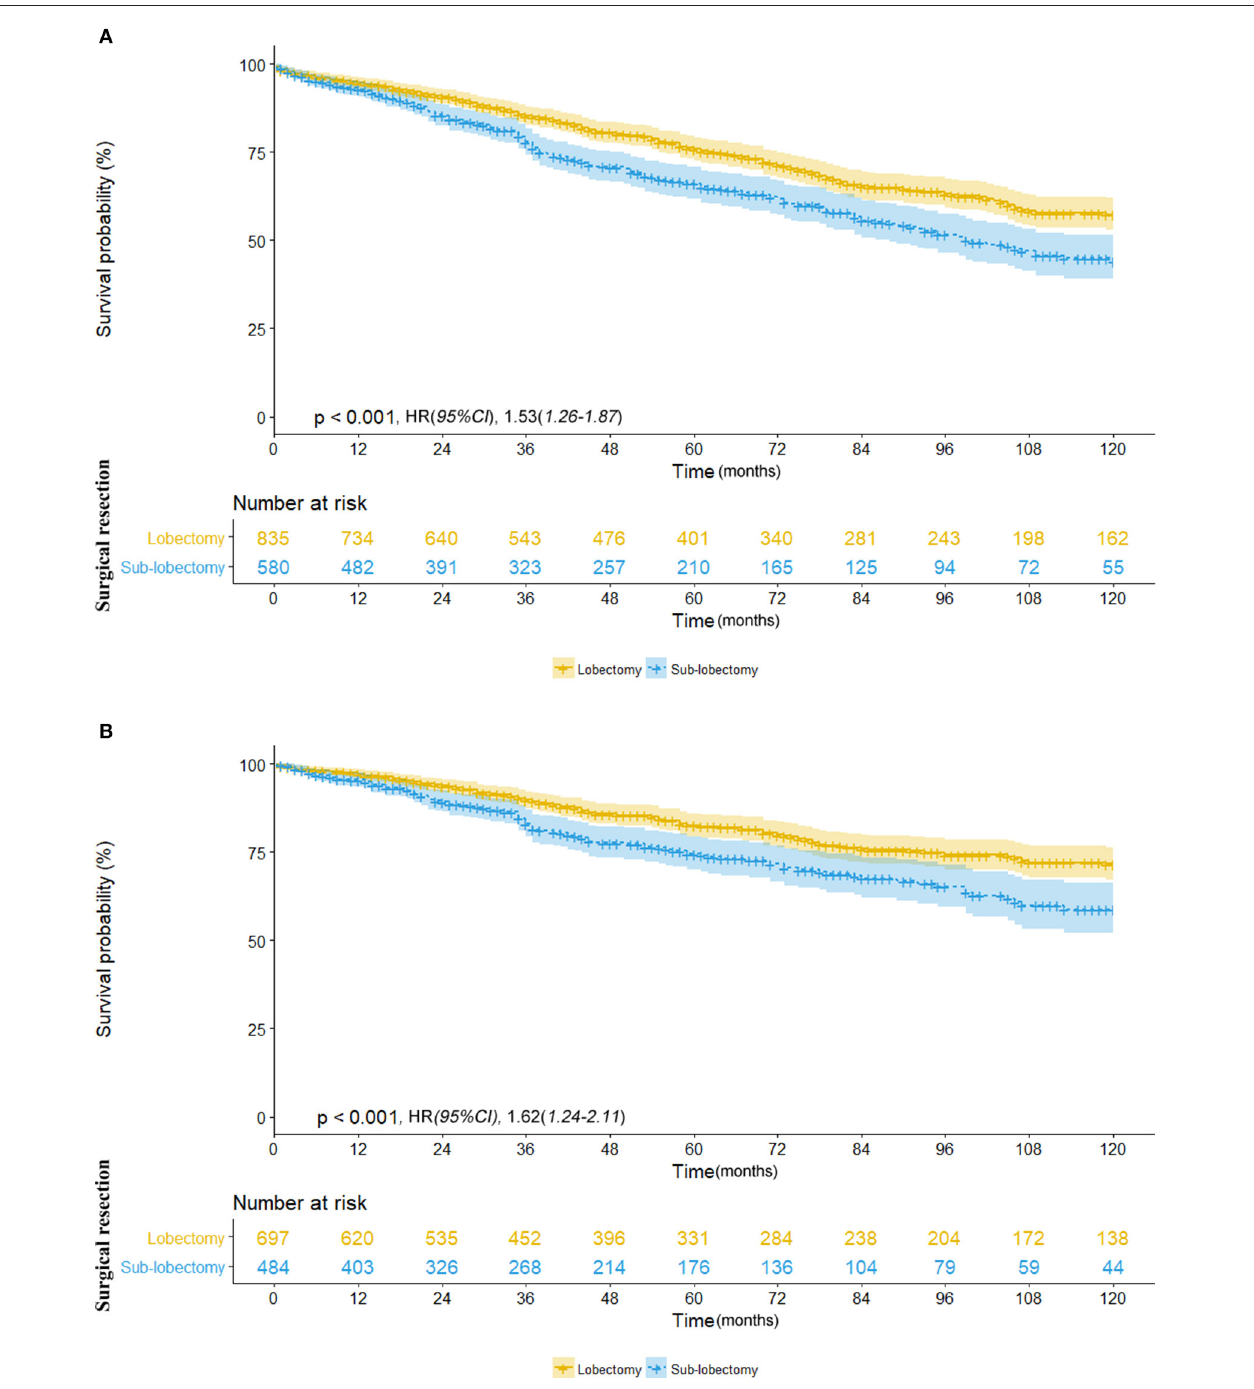
patient and tumor variables, non-surgery was found to be independently associated with poorer OS and CSS than surgery in patients with NSCLC ≤ 8 mm in